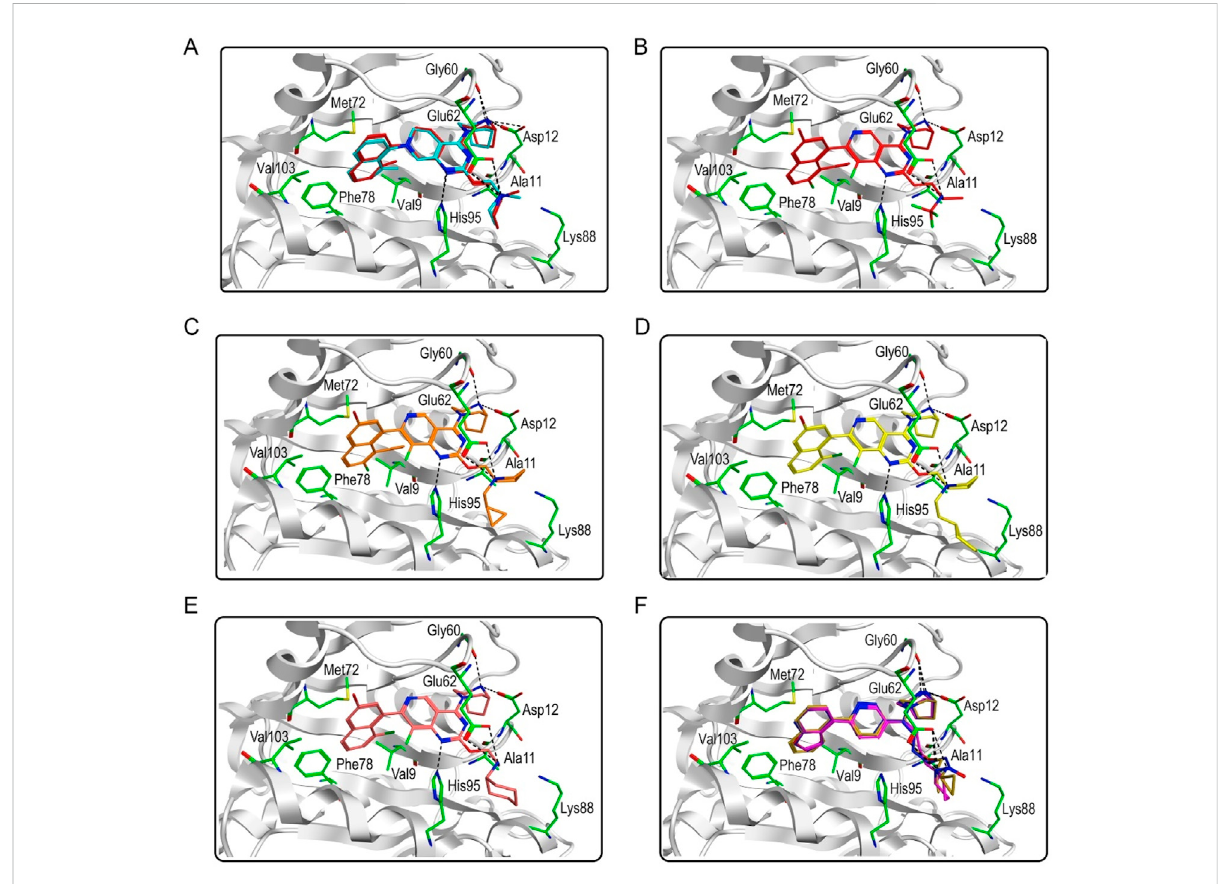
FIGURE 4 Predicted bindingmodes. (A) Thedockingconformation (red)and theactualconformation(cyan) oftheco-crystallizedligandTH-Z835; (B) Hit compound 1; (C) Hit compound 2; (D) Hit compound 3; (E) Hit compound 4; (F) Hit compounds 5 –